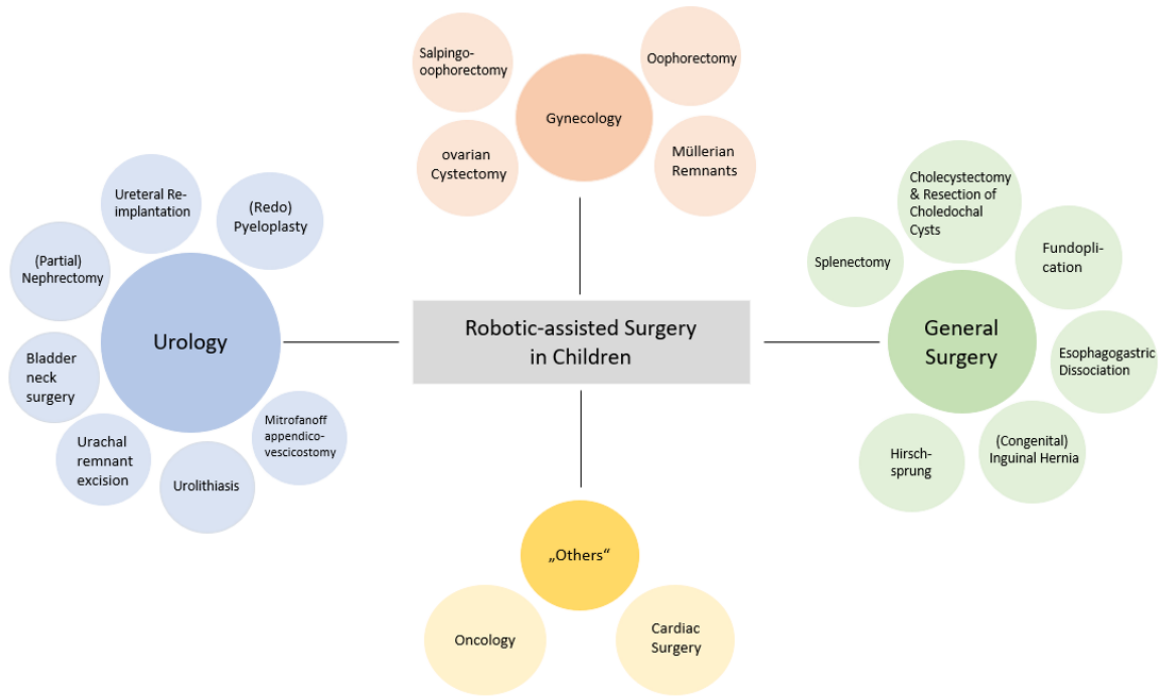
Figure 1. Summarized advantages and limitations of robotically assisted surgery in children.